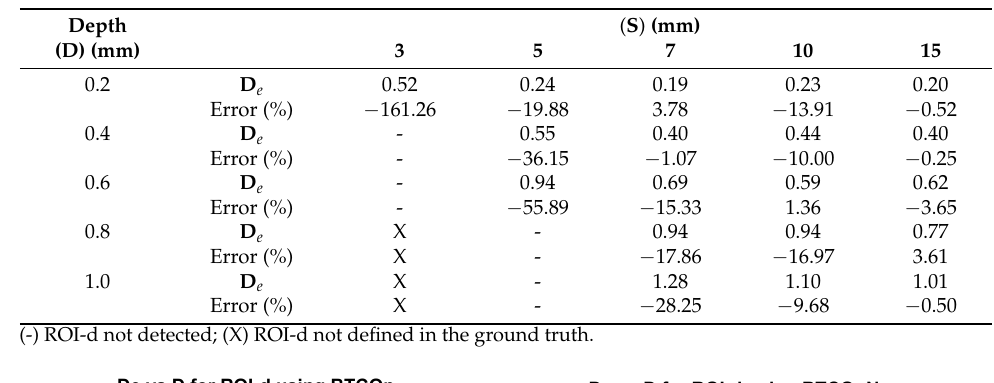
Table 9. Estimated depths ( D e ) and relative percentage errors (%) of defects for maxigrams of actual thermal sequences processed by the BTCOpN method.